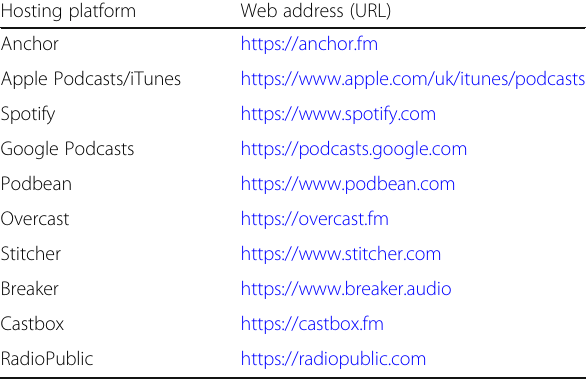
Table 1 Web addresses for each hosting platform